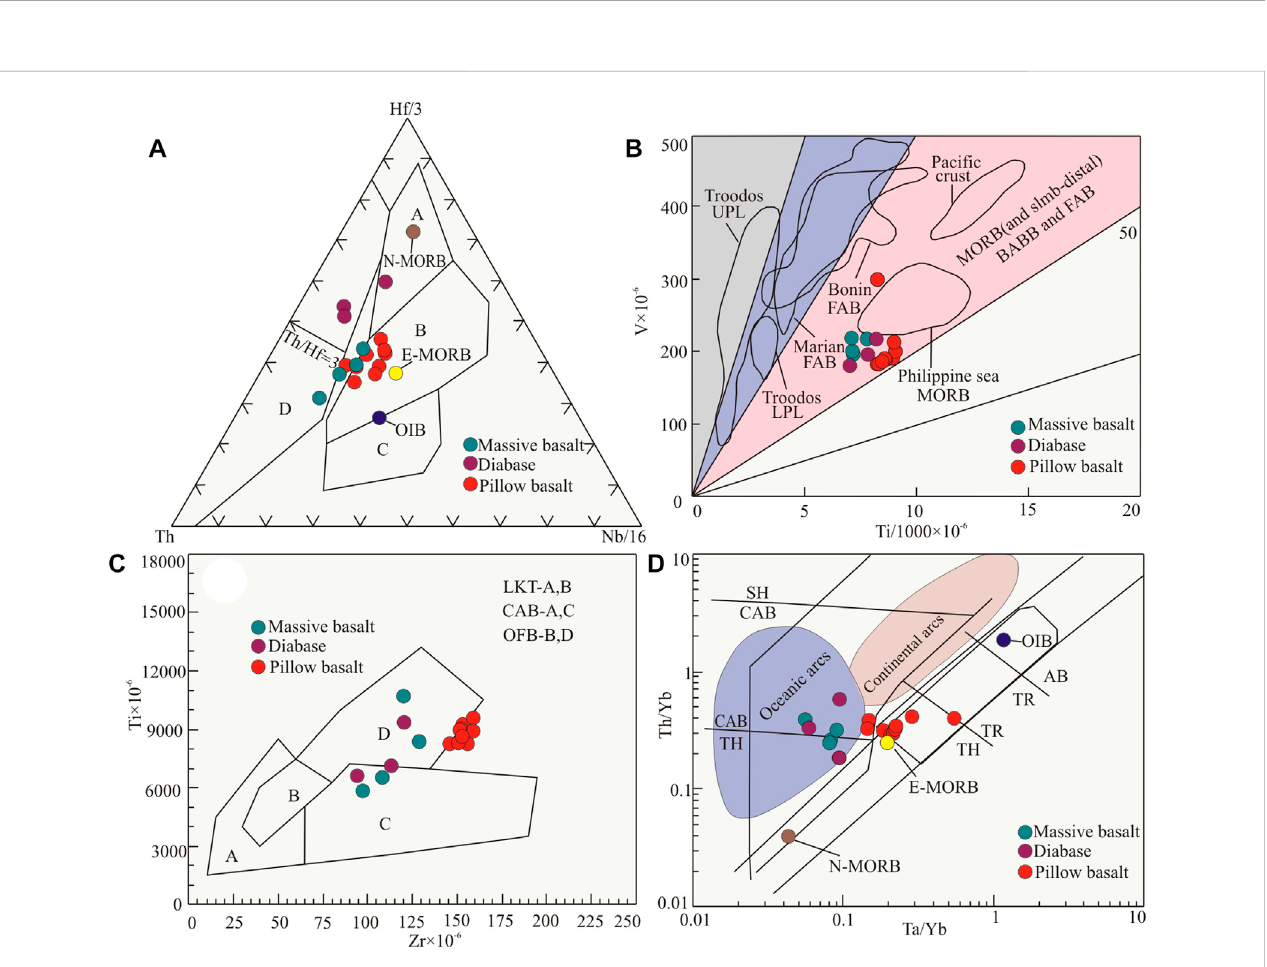
FIGURE 10 (A) Th-Hf-Nbdiagram(Wood,1980); (B) V-Tidiagram(Shervais,1982); (C) Zr-Tidiagram(PearceandCann,1973);and (D) Ta/Yb-Th/Ybdiagram(Pearce, 1982) of the basic igneous rocks in the Bairin Right Banner area, Inner Mongolia. A, N-type MORB; B, E-type MORB and tholeiitic within-plate basalts and differentiates;C,Alkalinewithin-platebasaltsanddifferentiates;D,Destructiveplate-marginbasaltsanddifferentiates(Th/Hf > 3belongtoCalc-alkalinebasalt; Th/Hf < 3 belong to tholeiitic basalt); BABB, back-arc basin basalt; FAB, fore-arc basalt; MORB, mid-ocean ridge basalt; LPL, lower pillow basalt; UPL, upper pillow basalt; LKT-A, B: low potassium tholeiite; CAB-A, C: calk-alkaline basalt; OFB-B, D: ocean fl oor basalt; AB: alkaline basalt; CAB: calk-alkaline basalt; SH: shoshonite; Th: tholeiitic basalt; TR: transitional